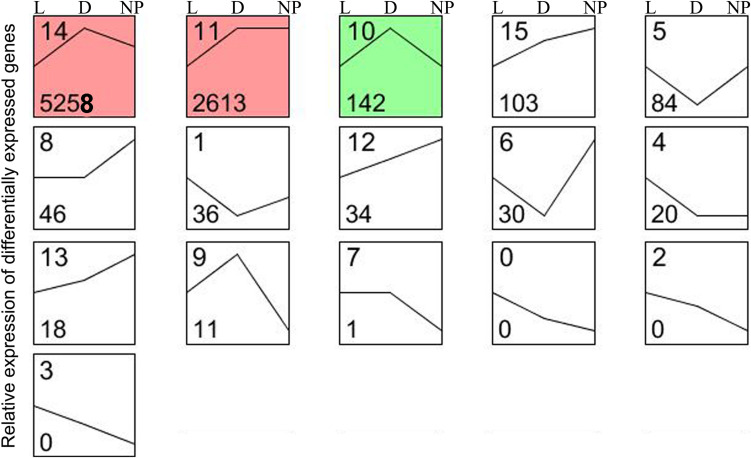
Sixteen patterns encompassing the DEGs during different stages of lactation using STEM software. L, peak lactation period; D, dry-off period; NP, non-lactating/non-pregnant period. Clusters ordered based on number of genes, and profiles ordered by significance. The number in the top left-hand corner of a profile box is the profile ID number, and the number in the bottom left-hand corner of a profile box is the profile gene number. The colored profiles had a statistically significant number of genes assigned. Non-white profiles of the same color represent profiles grouped into a single cluster.